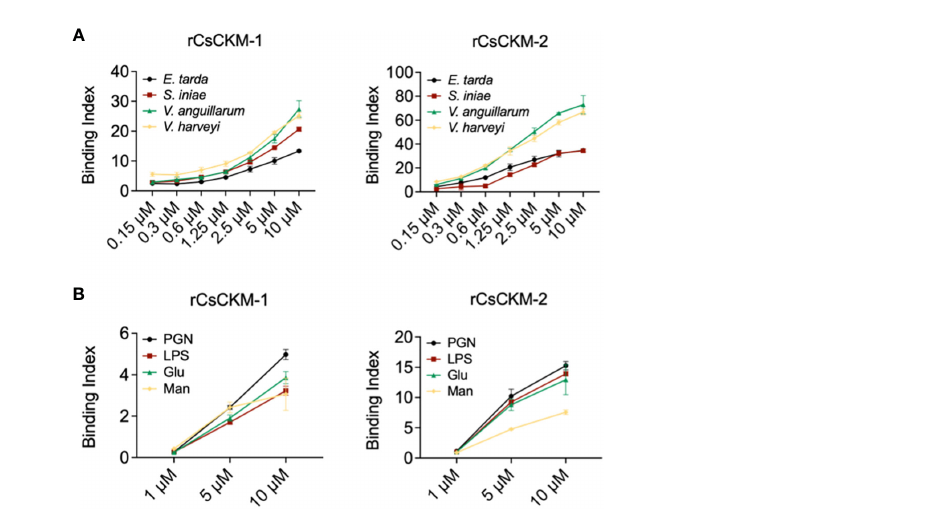
FIGURE 3 Binding of CsCKM-1/2 to bacteria and bacterial cell surface components. (A) rCsCKM-1/2 in different concentrations were incubated with Edwardsiella tarda , Vibrio anguillarum , Vibrio harveyi and Streptococcus iniae , and the binding was determined by ELISA. (B) The binding of rCsCKM- 1/2 to different pathogen-associated molecular patterns (PAMPs) was determined by ELISA. LPS, lipopolysaccharides; PGN, peptidoglycan; Glu, glucan; Man, mannan. Values are the means of triplicate assays and shown as means ±